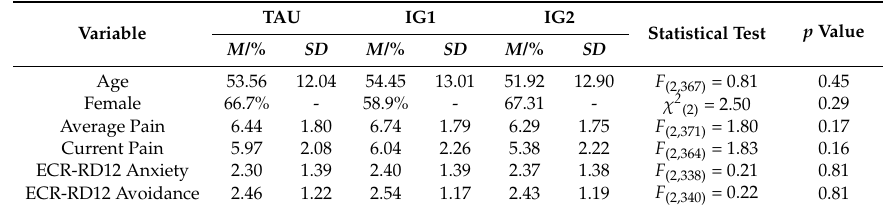
Table 2. Descriptive details of the core study variables and differences between the three treatment groups, n = 374.